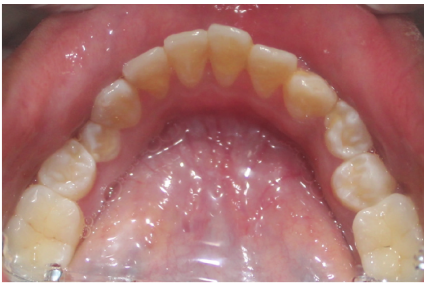
Figure 5: Intraoral picture showing mandibular arch with distoan- gular rotation of 34 and mesioangular rotation of 44.